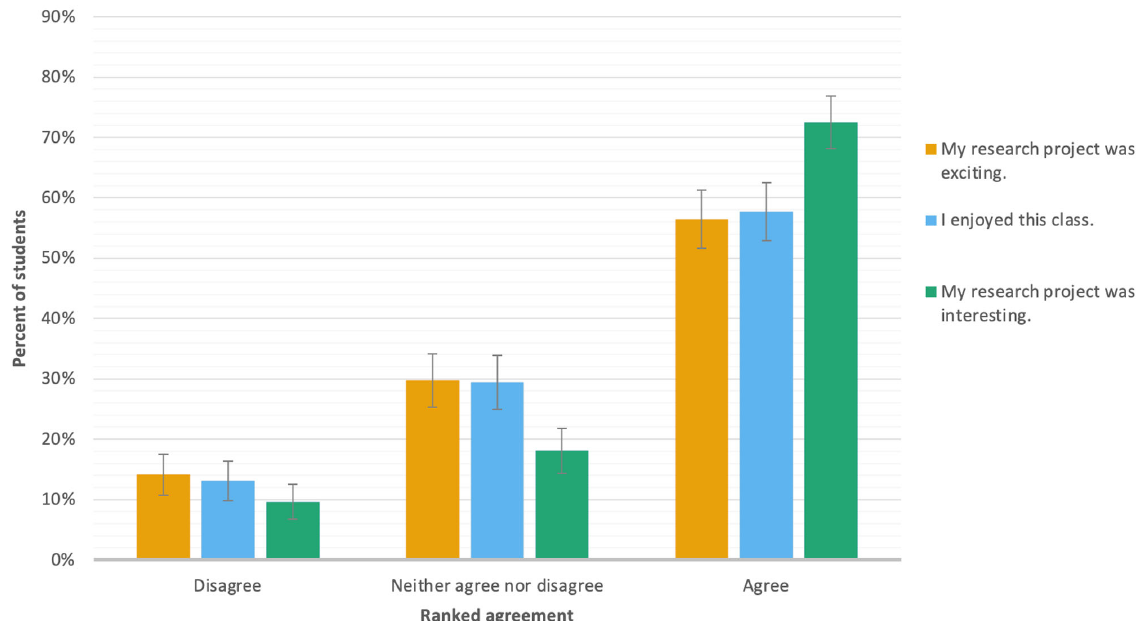
FIG. 8. Students ranked agreement with affective questions about the course in the postcourse survey. Students responded to a 5-point Likert scale from strongly disagree to strongly agree. The responses presented in the graph have been collapsed to a 3-point scale. The uncertainty was calculated using the 95% binomial confidence interval with n ¼ 404